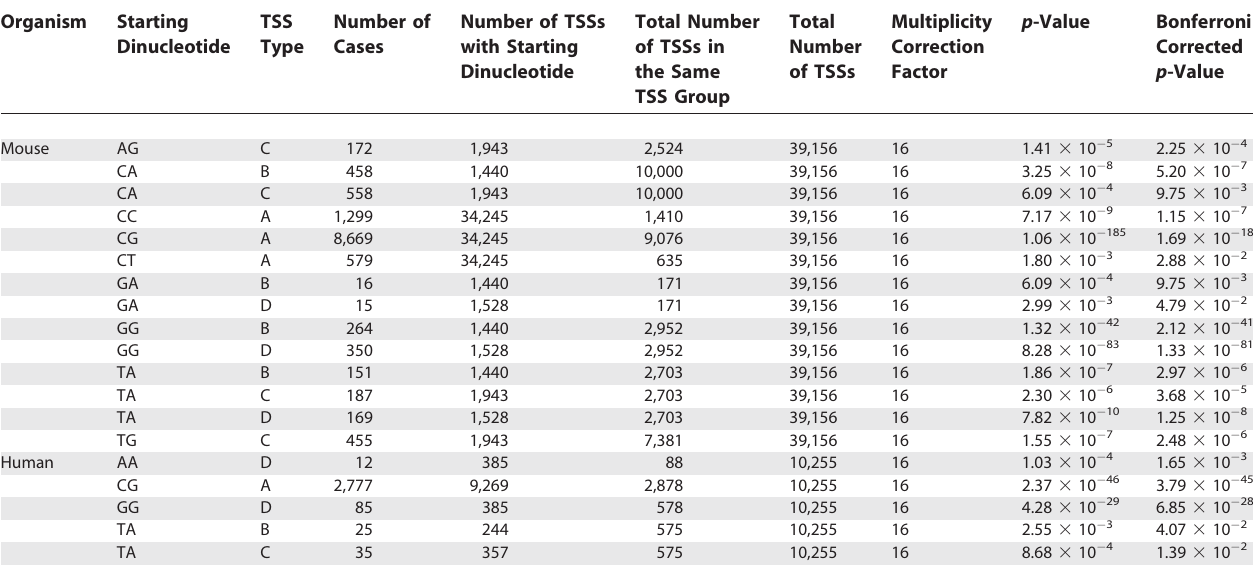
Table 2. Starting Dinucleotide [ (cid:2) 1, þ 1] for Various TSS Types in Mouse and Human Datasets